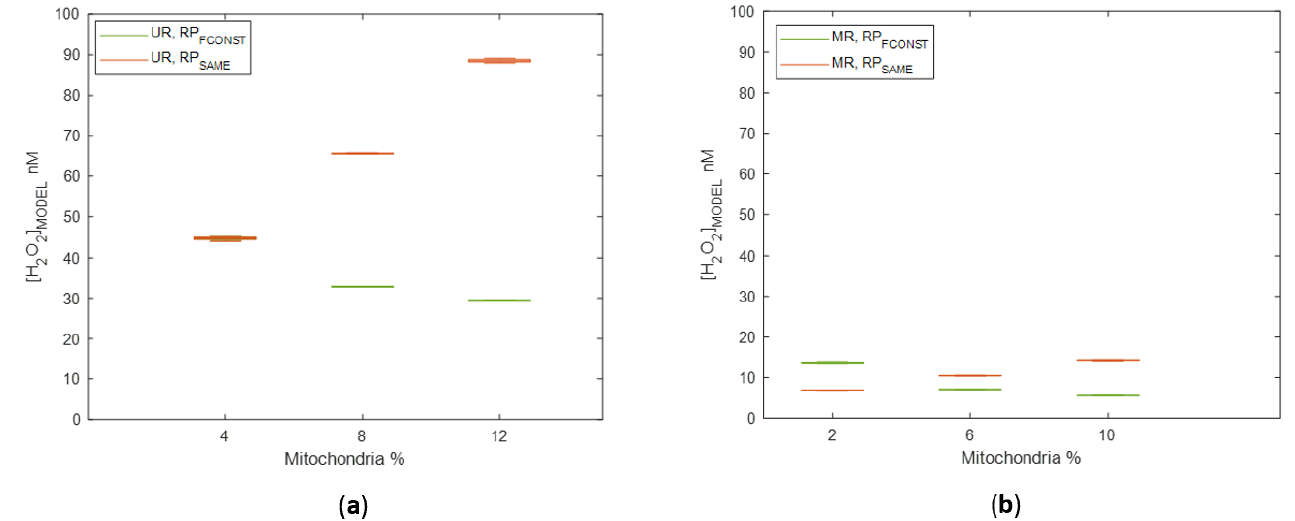
Figure 5. Sample H 2 O 2 concentrations ([H 2 O 2 ]) depend on mitochondrial volume ratio for ROS production models RP SAME and RP FCONST : ( a ) Mean H 2 O 2 concentrations for simulations of unmyelinated regions (UR); ( b ) Mean H 2 O 2 concentrations for simulations of myelinated regions (MR).